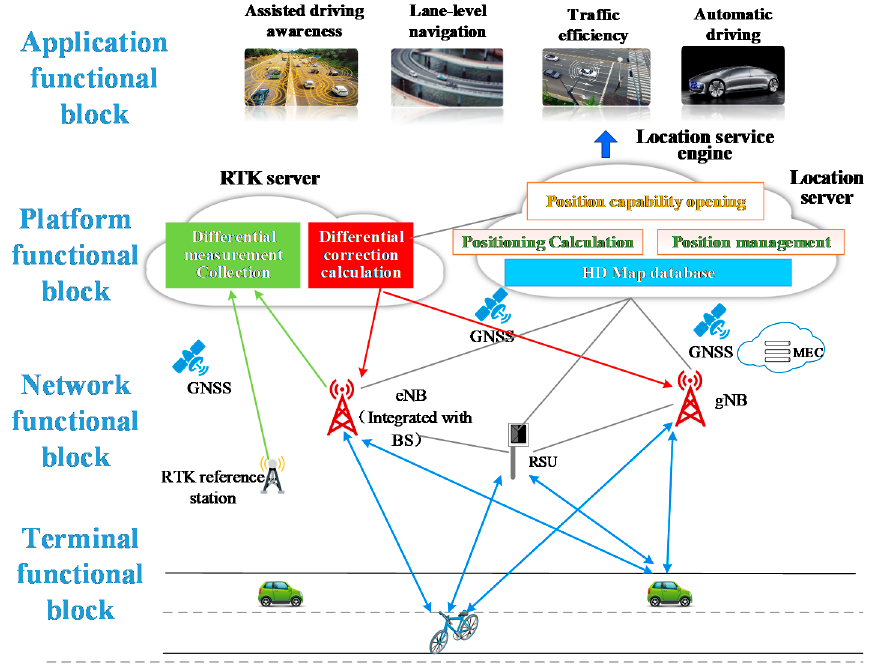
Figure 6. UE-assisted Positioning Architecture of V2X system.